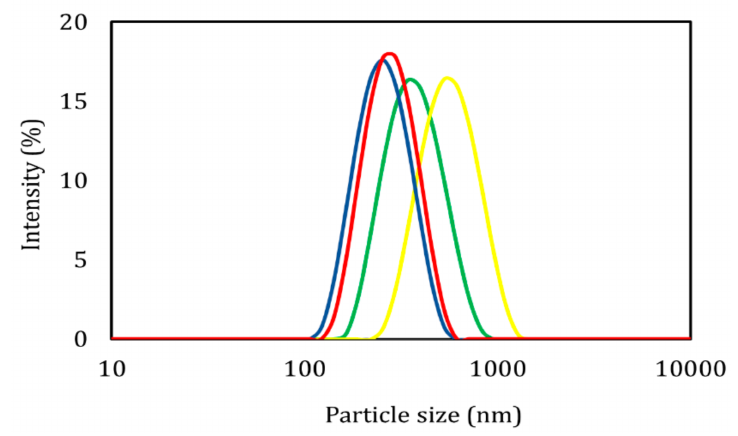
Figure 1. Distribution of the particle size obtained for the di ff erent treatments.